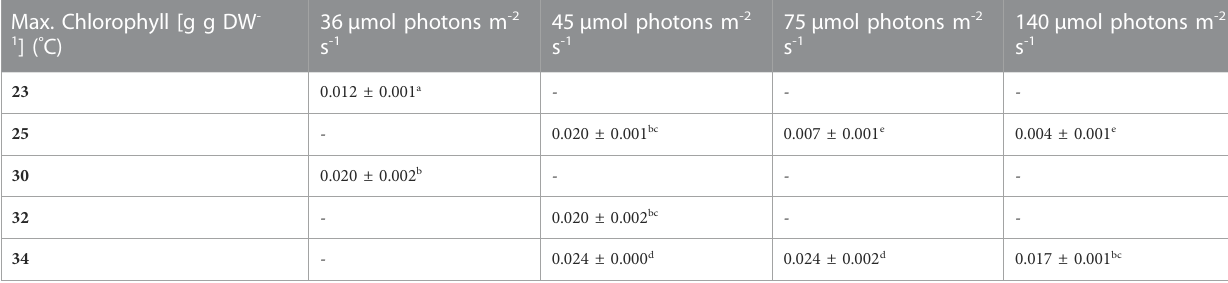
TABLE 9 Maximum chlorophyll content, the values are shown as mean ± SD of four to eight cultures.